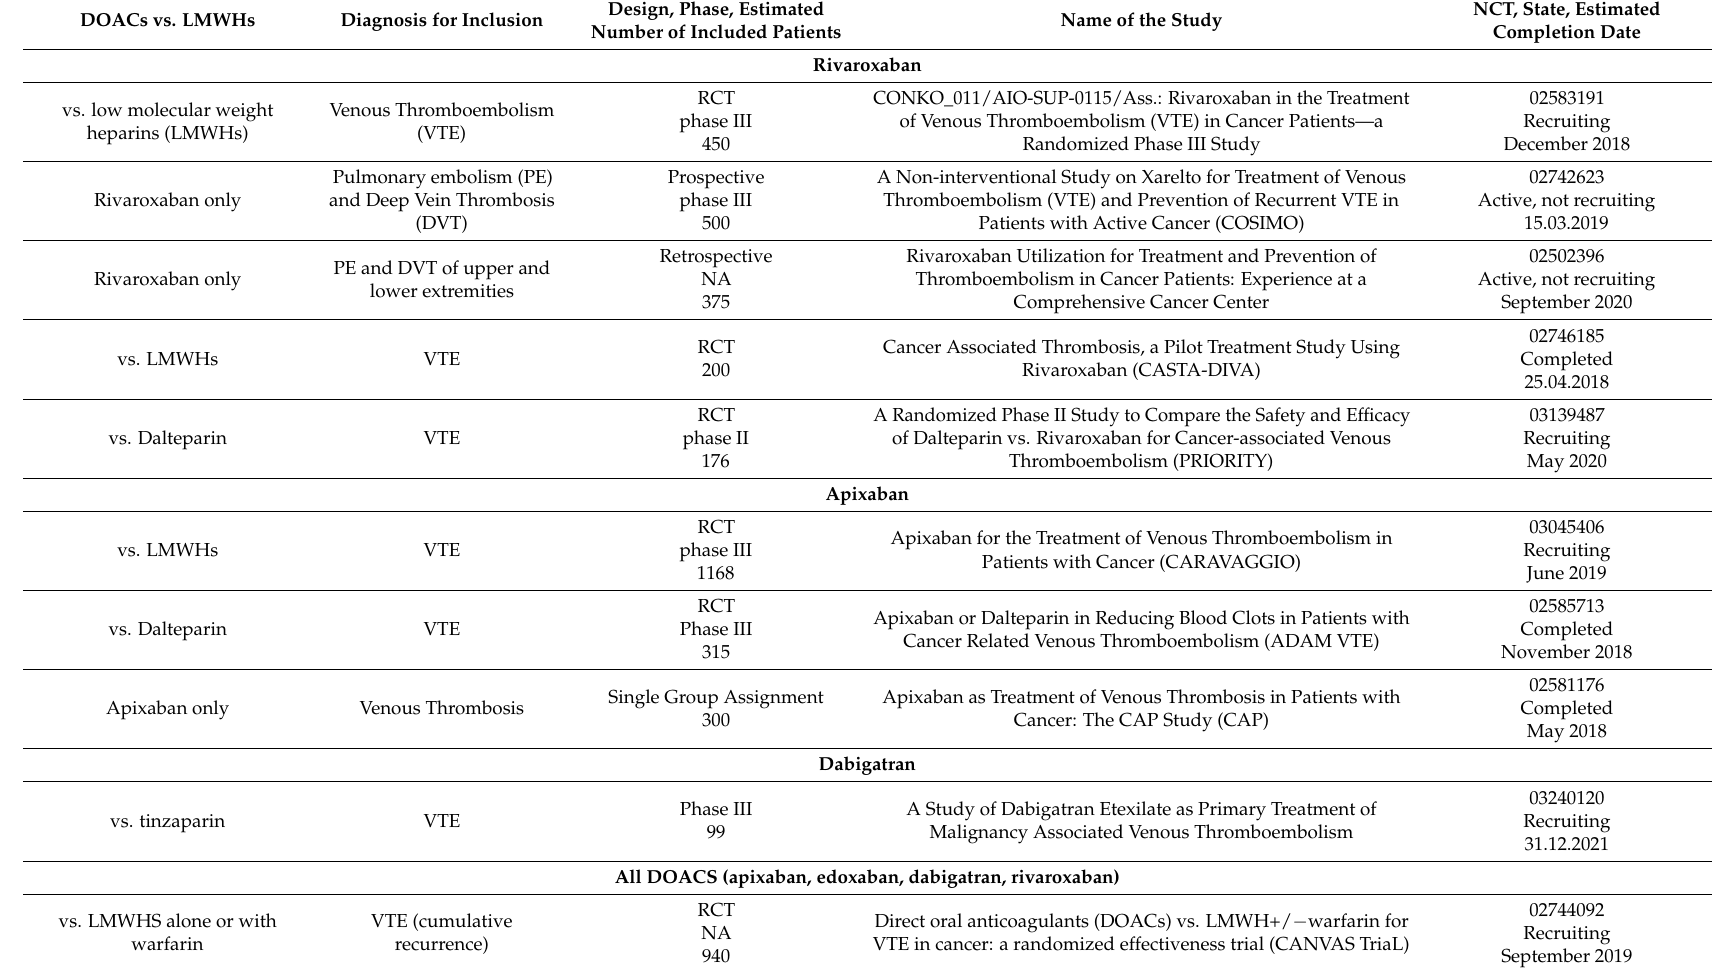
Table 1. Summary of the ongoing or in 2018 concluded clinical